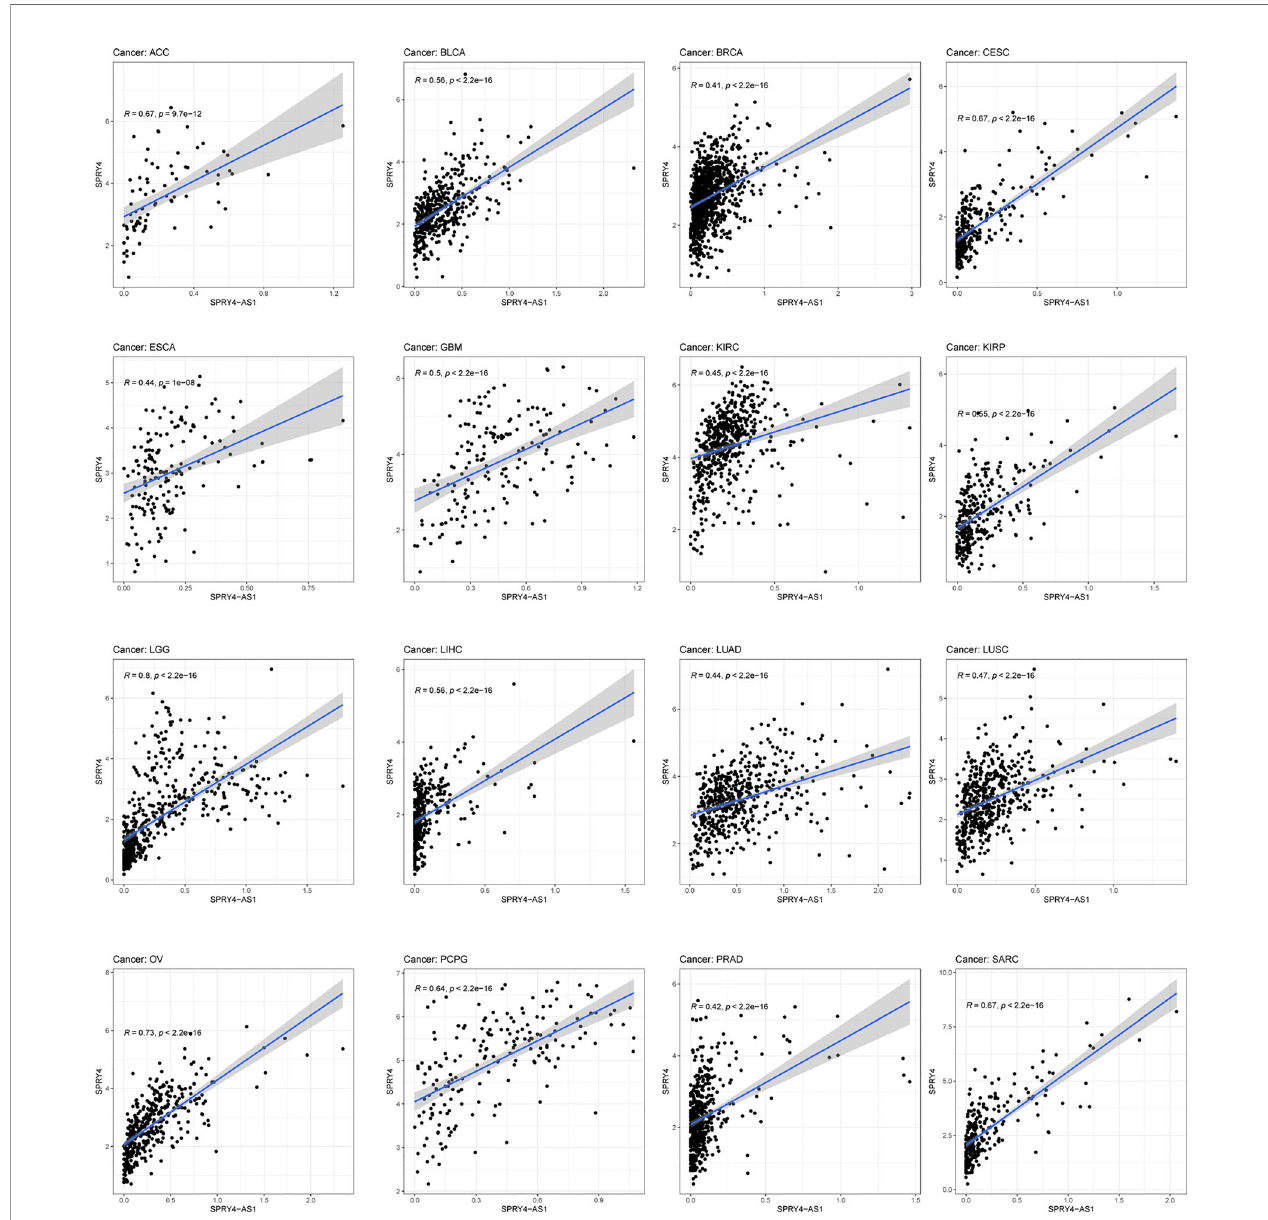
FIGURE 6 | The association between SPRY4 antisense RNA 1 (SPRY4-AS1) and SPRY4 in